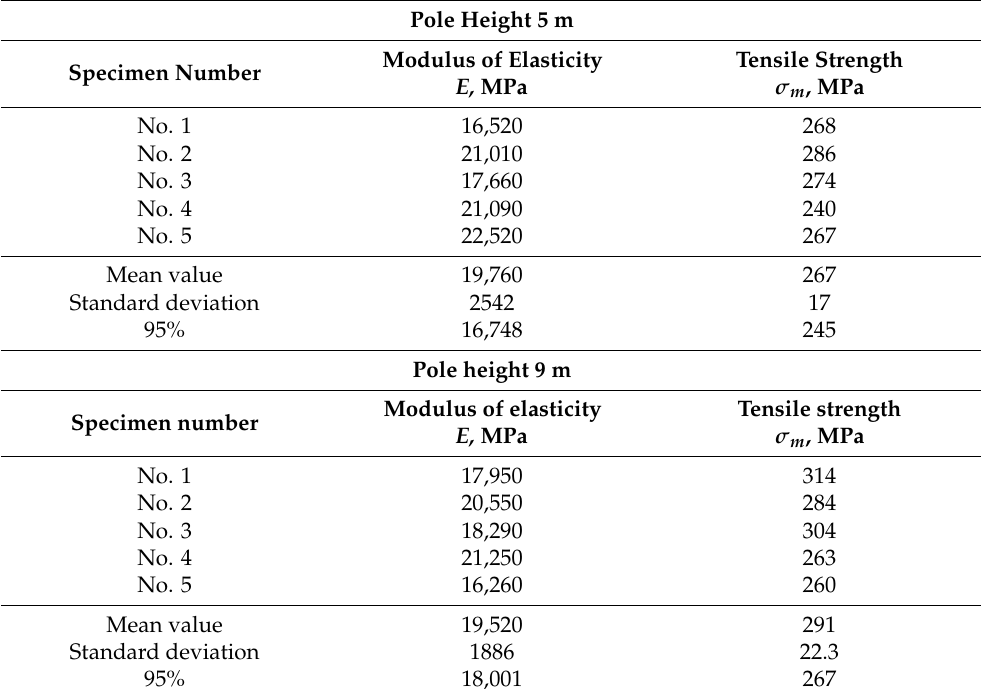
Table 2. Results of flexural tests (mean values and standard deviations).